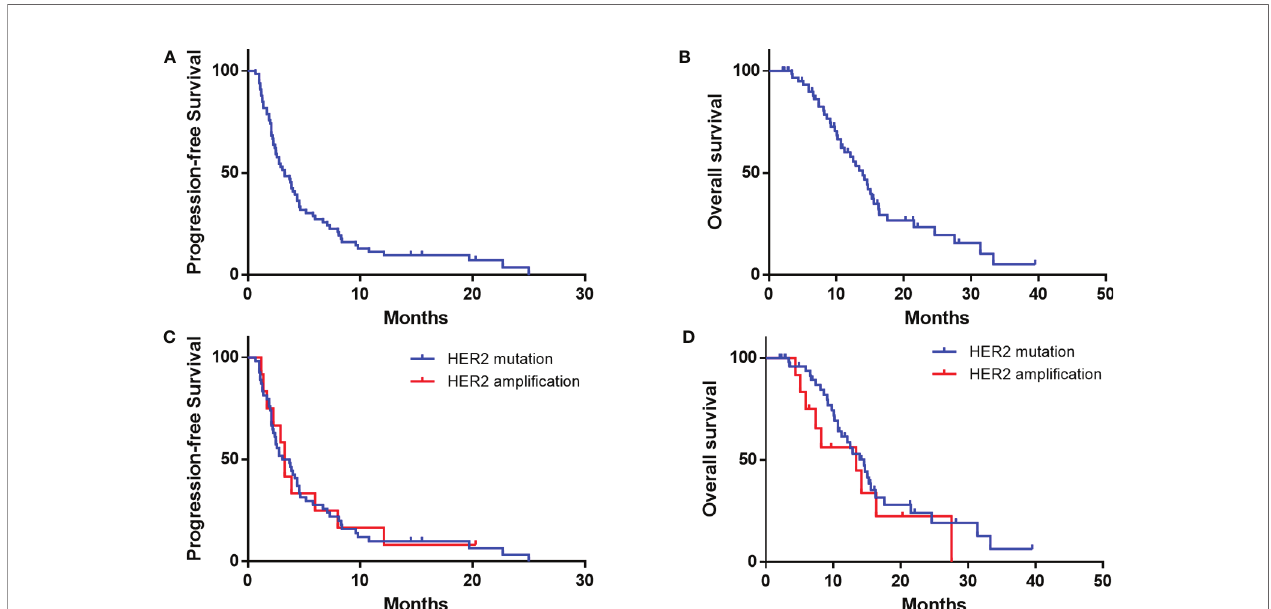
FIGURE 3 | Kaplan – Meier estimates of progression-free survival and overall survival of NSCLC Patients with HER2 alterations. (A, B) progression-free survival and overall survival of the whole cohort; (C, D) progression-free survival and overall survival according to HER2 mutations or ampli fi